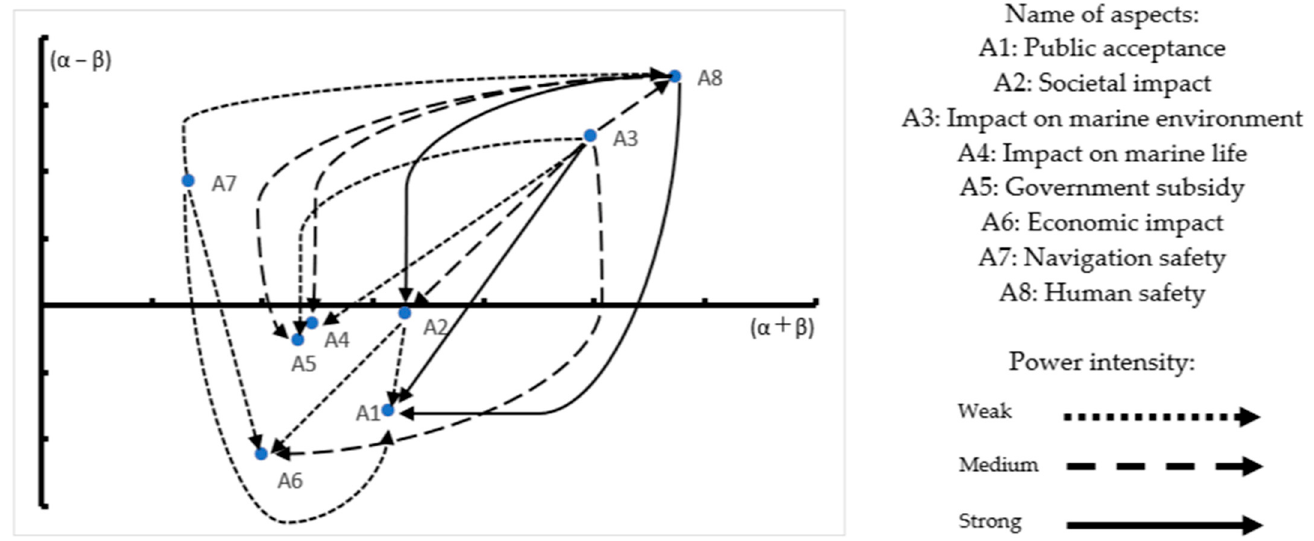
Figure 1. Risk assessment cause and effect model of aspects. Undergoing a similar procedure, the crucial criteria are obtained. Table 7 presents the cause–effect model for the Table 7. Cause–effect model for criteria.